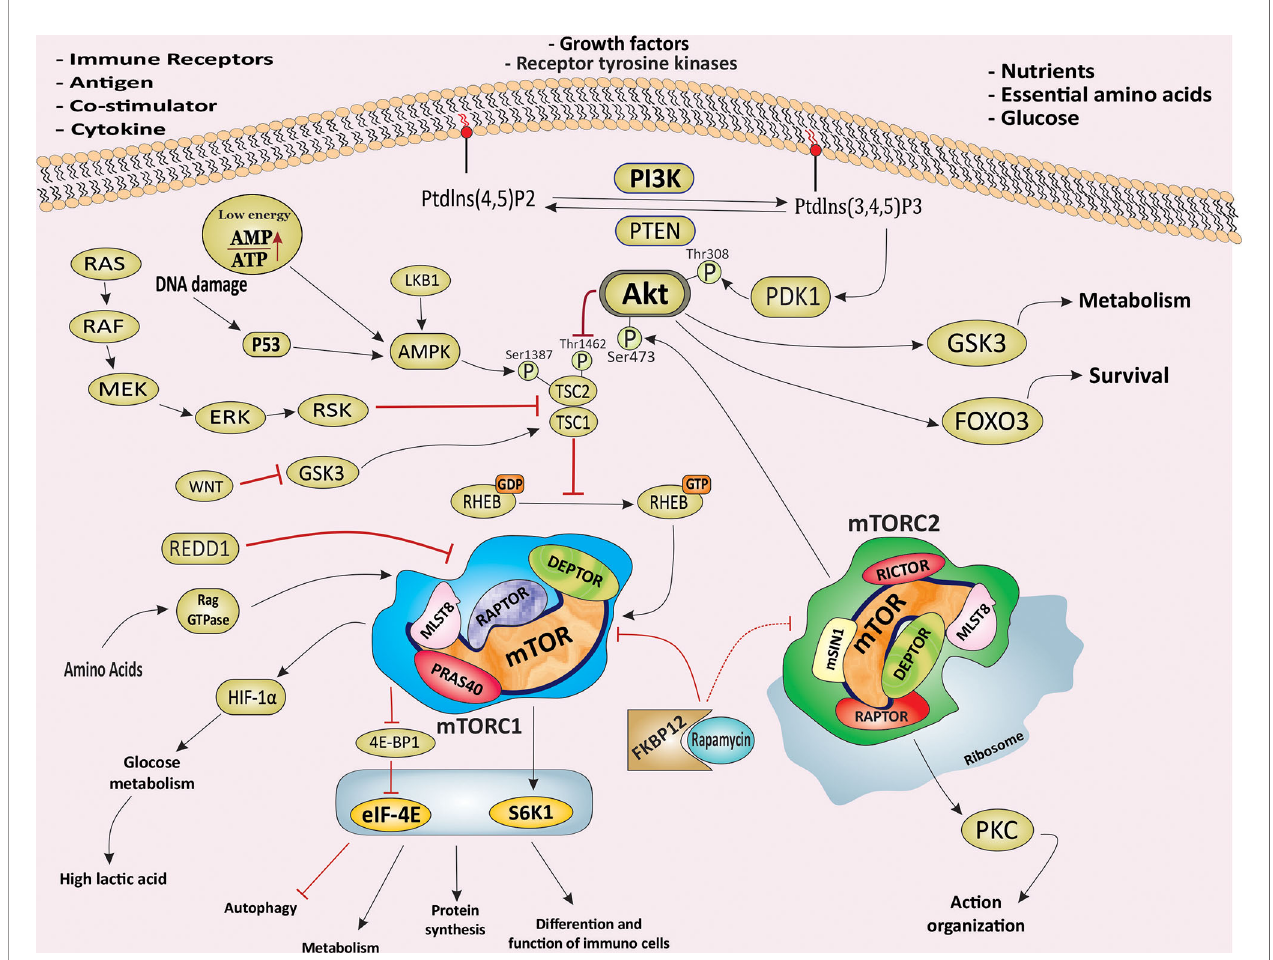
FIGURE 1 | The PI3K/Akt/mTOR signaling pathway and signaling pathway of mTORC1 and mTORC2. Schematic illustration of the molecular components and signaling events related to the PI3K/Akt/mTOR signaling pathway and its main downstream effectors. Schematic showing the main molecular components and signals sensed by mTORC1 and mTORC2 and the processes they regulate to control main cellular events, including growth, protein synthesis, metabolism, survival and proliferation. mTOR, mechanistic target of rapamycin; PI3K, phosphoinositide 3 kinase; mTORC1, mTOR complex 1; mTORC2, mTOR complex 2; RAPTOR, regulatory-associated protein of mTOR; RICTOR, rapamycin-insensitive companion of mTOR; mSIN1, mammalian stress-activated protein kinase interacting protein; eIF4E, eukaryotic initiation factor 4E; 4EBP1, eIF4E -binding protein 1; S6K1, S6 kinase 1; HIF-1 a , Hypoxia Inducible Factor 1 a ; PKC, Protein kinase C; AMPK, AMP activated protein kinase; SGK1, glucocorticoid regulated kinase 1; FKBP12, FK506 Binding Protein 12; LKB1, liver kinase B1; DEPTOR, DEP-containing mTOR interacting protein; mLST8, mammalian lethal with Sec13 protein; RAPTOR, regulatory-associated protein of mTOR; PRAS40, proline-rich AKT substrate 40 kDa; mSin1, mammalian stress-activated protein kinase (SAPK)-interacting protein 1; Rheb, RAs homologue enriched in brain; TSC, tuberous sclerosis complex; GSK3, Glycogen synthase kinase-3; PDK1, Phosphoinositide-dependent Kinase 1; FOXO3, Forkhead box family transcription factors 3; PTEN, phosphatase and tensin homologue; REDD1, regulated in development and DNA damage responses